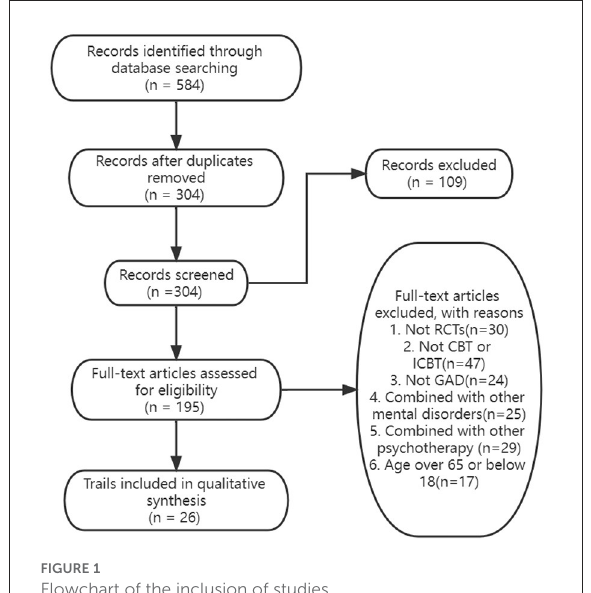
FIGURE1 Flowchart of the inclusion of studies.